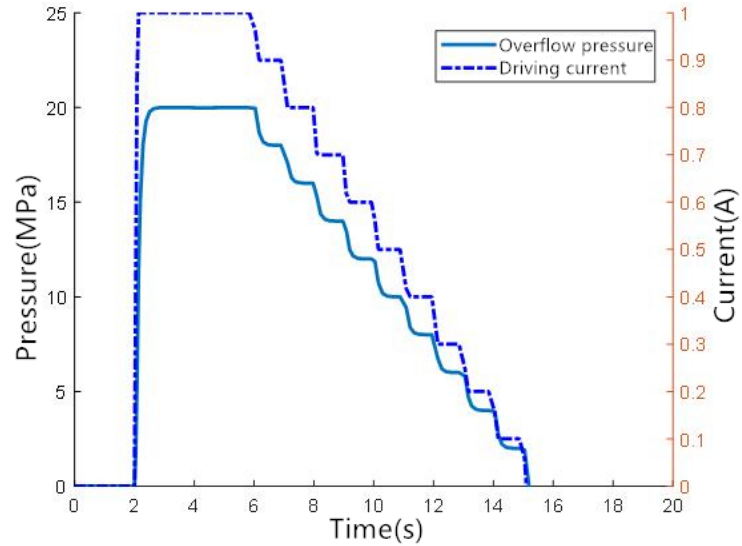
Figure 11. The overflow characteristic curve of the solenoid valve.